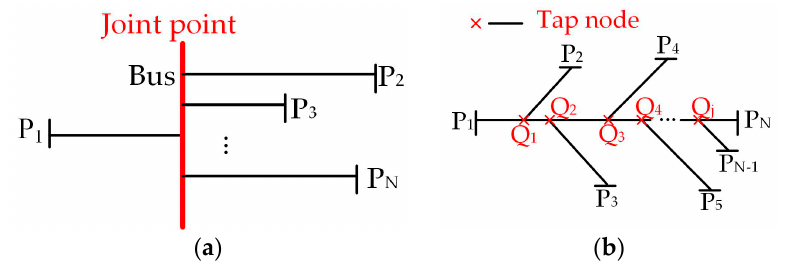
Figure 1. Structure diagram of the multi-terminal radial lines: type ( a ) and type ( b ).